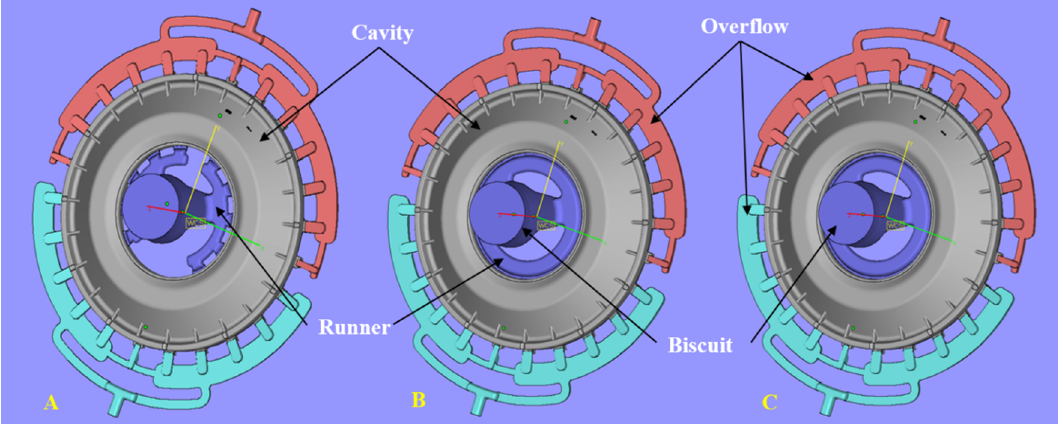
Figure 2. Casting model of cooking grill: ( A ) Case 1; ( B ) Case 2; ( C ) Case 3.